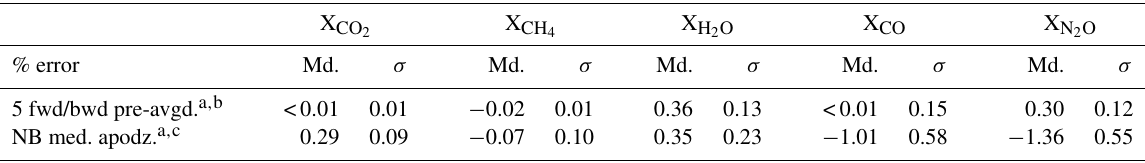
X H X CO X N X CH X CO 2 O 2 O 4 2